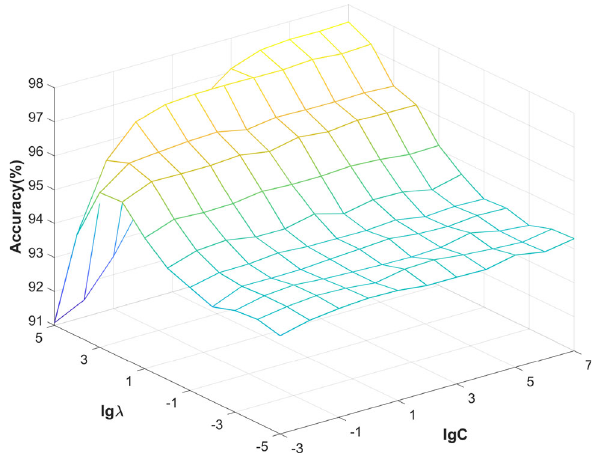
Fig. 6 The influence of the regularization parameter on the generaliza- tion performance